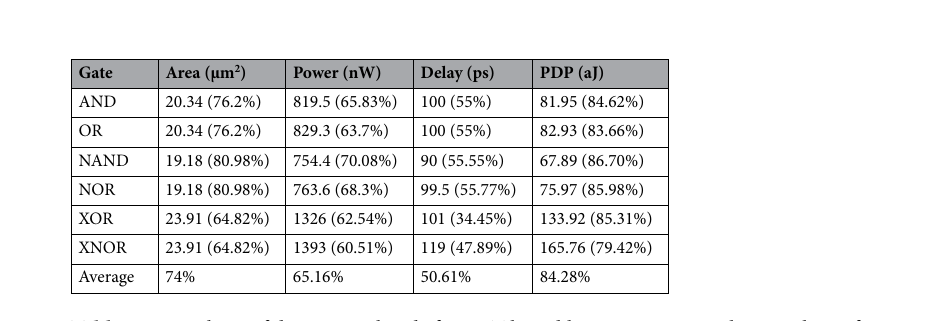
Table 24. Analysis of design overheads for LUT based logic encryption along with % of improvements when compared with proposed logic encryption.